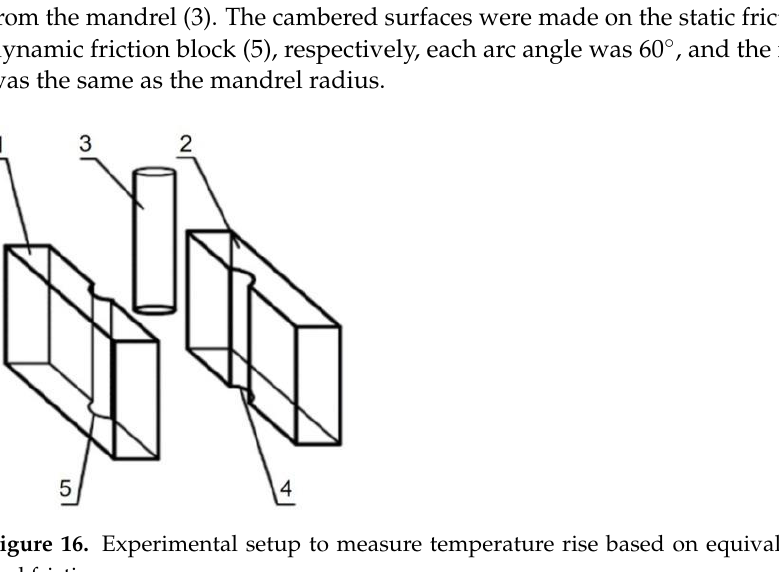
Figure 16. Experimental setup to measure temperature rise based on equivalent tool deflection and friction.